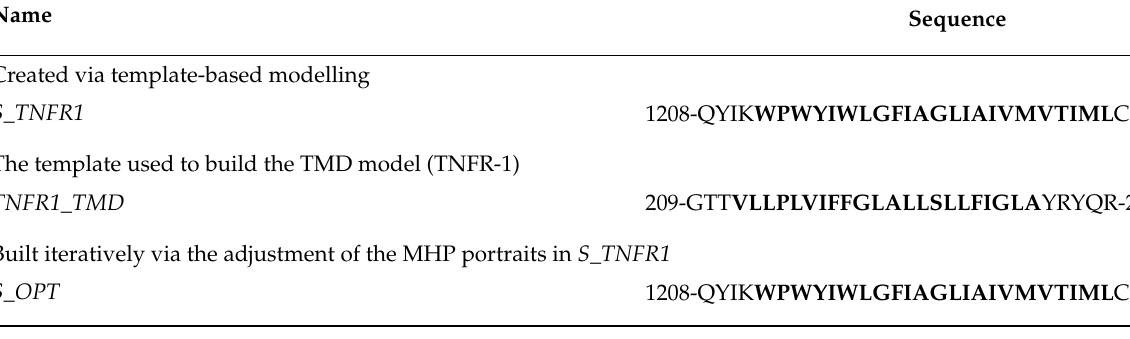
Table 1. Model trimers tested in the present